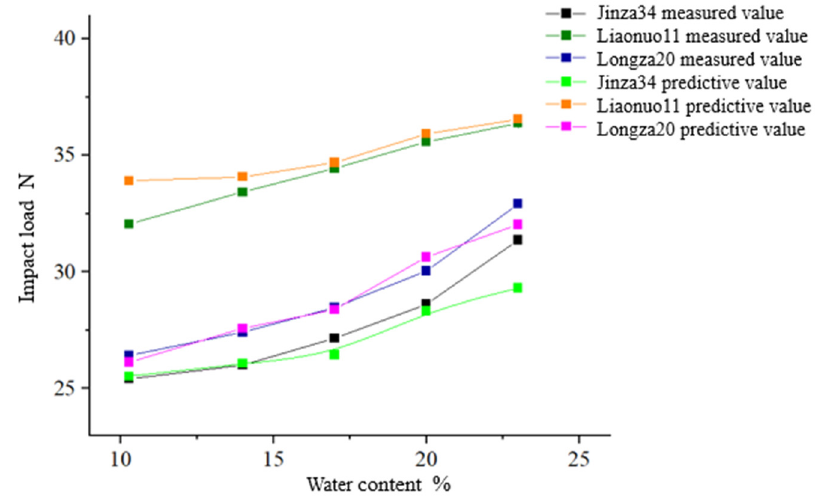
Figure 13. Impact of mechanical properties under different moisture content.